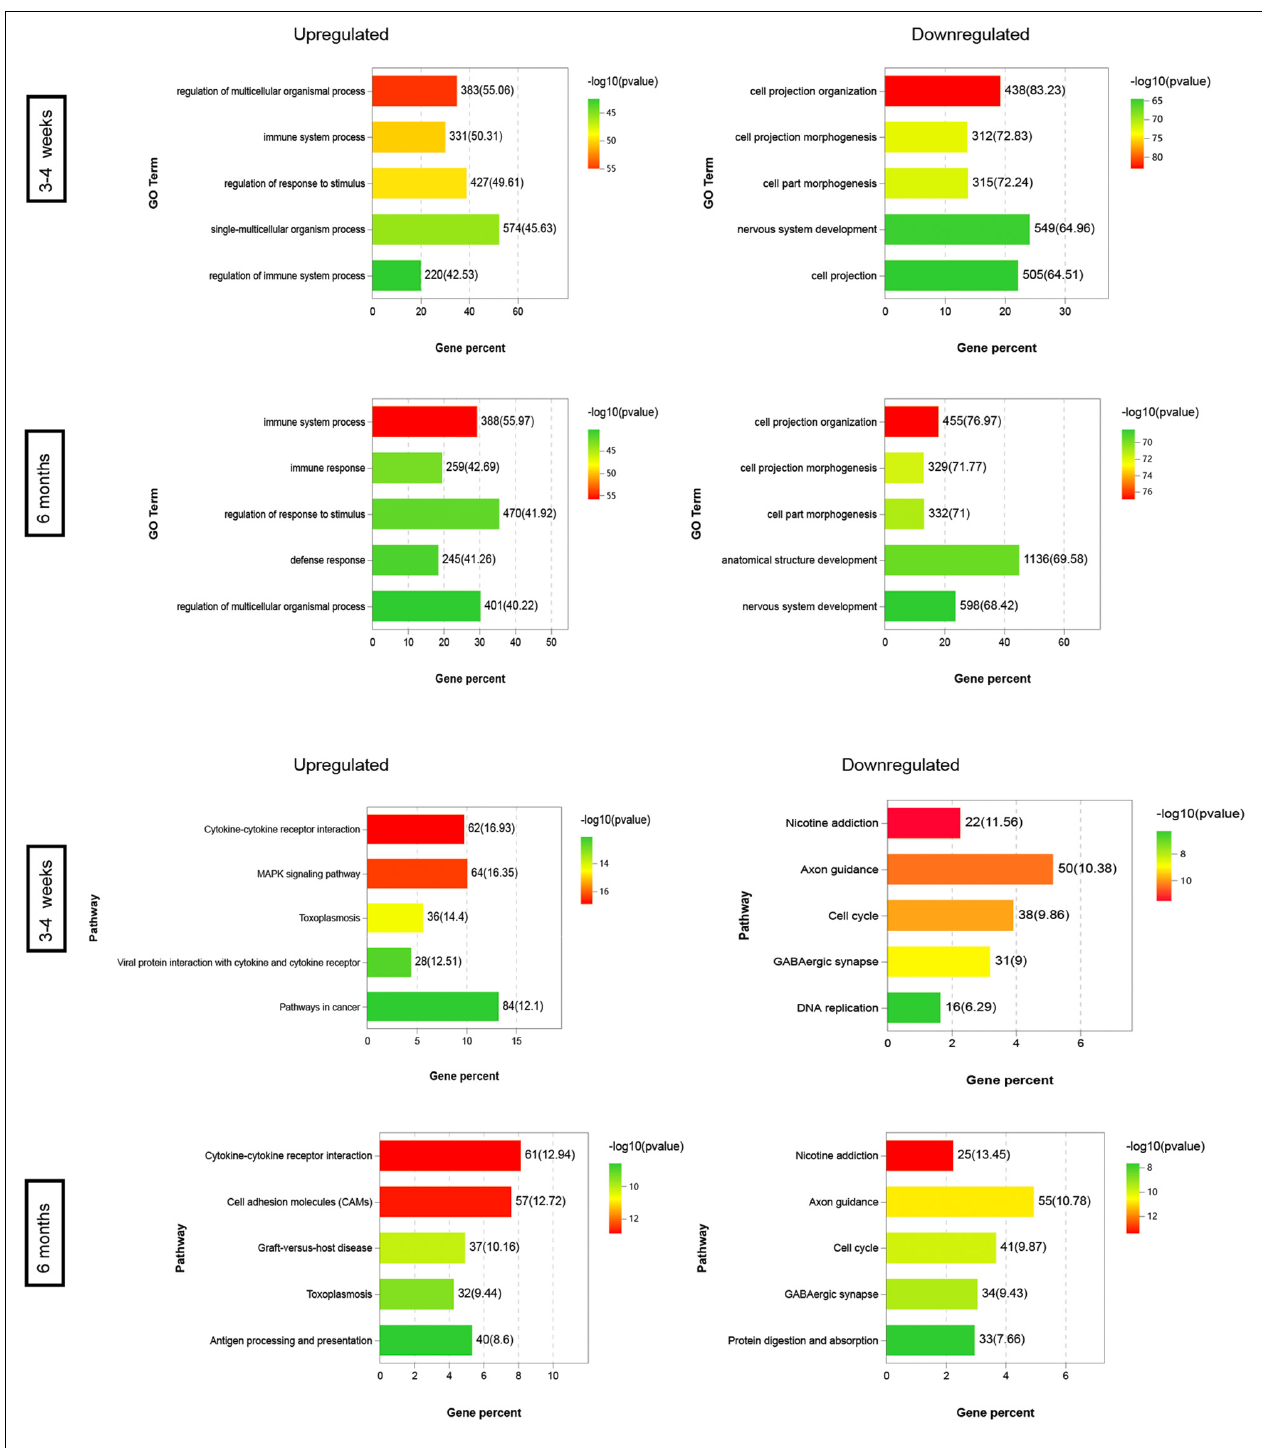
FIGURE 3 | Pathways altered in the microvascular endothelial cells during development. DAVID Bioinformatics were used to identify the most significantly upregulated and downregulated GO terms and KEGG pathways based on the transcriptional changes in microvascular endothelial cells at each time point during development. For the 3–4-week-old group and the 6-month-old group, genes were selected as upregulated if they are increased compared to 1-day-old group log2 (fold change) > 2.00, with FDR < 0.05, and downregulated compared to 1-day-old group if they are changed log2 (fold change) > –2.00, with FDR < 0.05. The heat map scale represents the top5 of the P value that the specified pathway is changed in the given time point during development. The top five of each of the GO terms and KEGG pathways are presented at each time point during development.